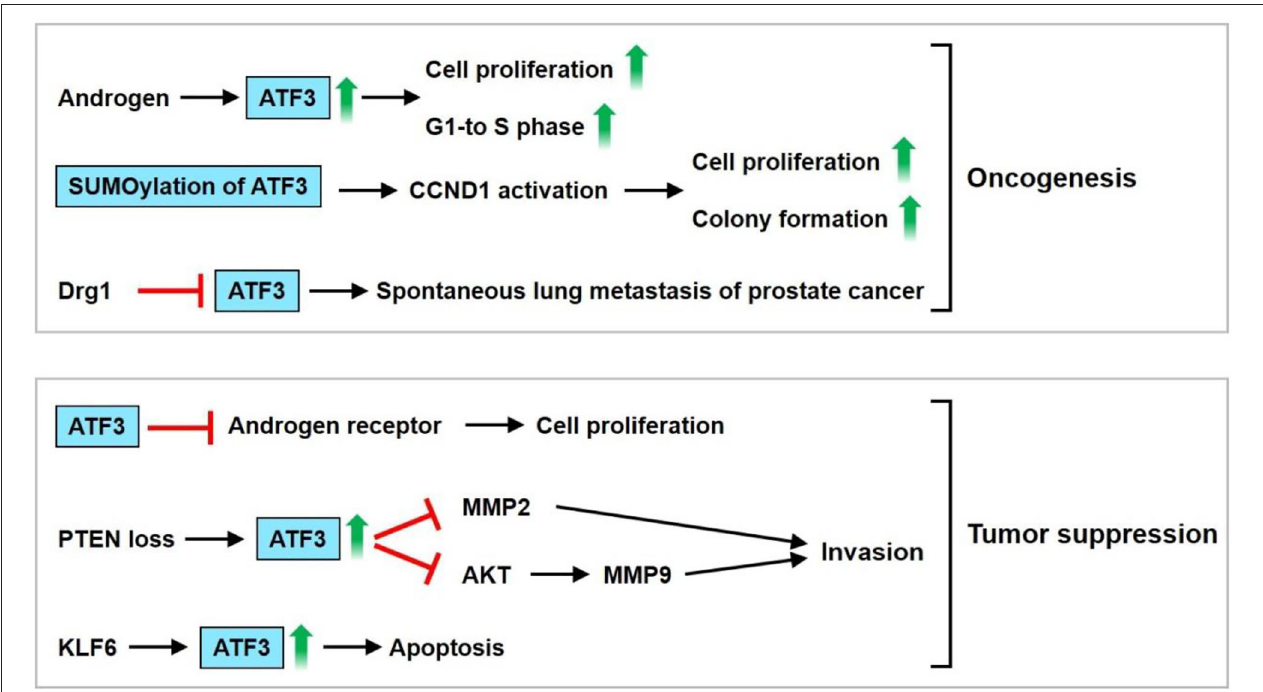
FIGURE 4 | ATF3 functions as an oncogene or tumor suppressor in prostate cancer. ATF3 may be upregulated by androgen, thus induces cell proliferation and G1-to-S-phase transition of the cell cycle. In addition, ATF3 SUMOylation enhanced cyclin D1 (CCND1) activation, resulting in increased cell proliferation and colony formation. ATF3 was downregulated by Drg-1, a suppressor of metastasis. These implied that ATF3 serves an oncogene. ATF3 may act as a tumor suppressor by inhibiting androgen receptor, MMP2, AKT, causing inhibition of cell proliferation and invasion. Furthermore, upregulation of ATF3 by KLF6 leads to cell apoptosis. In sum, these findings demonstrate that dual roles of ATF3 as an oncogene or tumor suppressor is observed in prostate cancer.